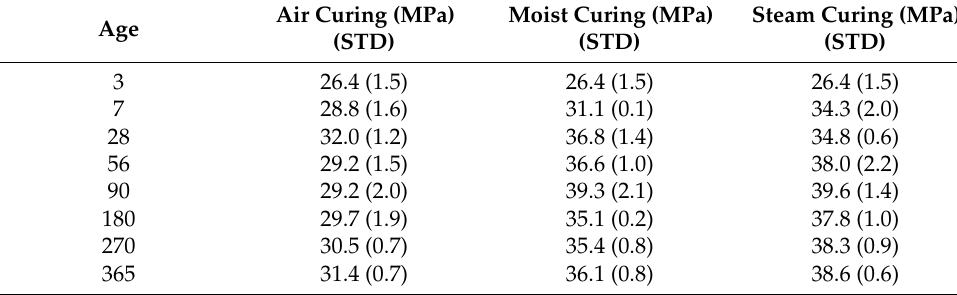
Table 7. Experiment results for flexural tensile